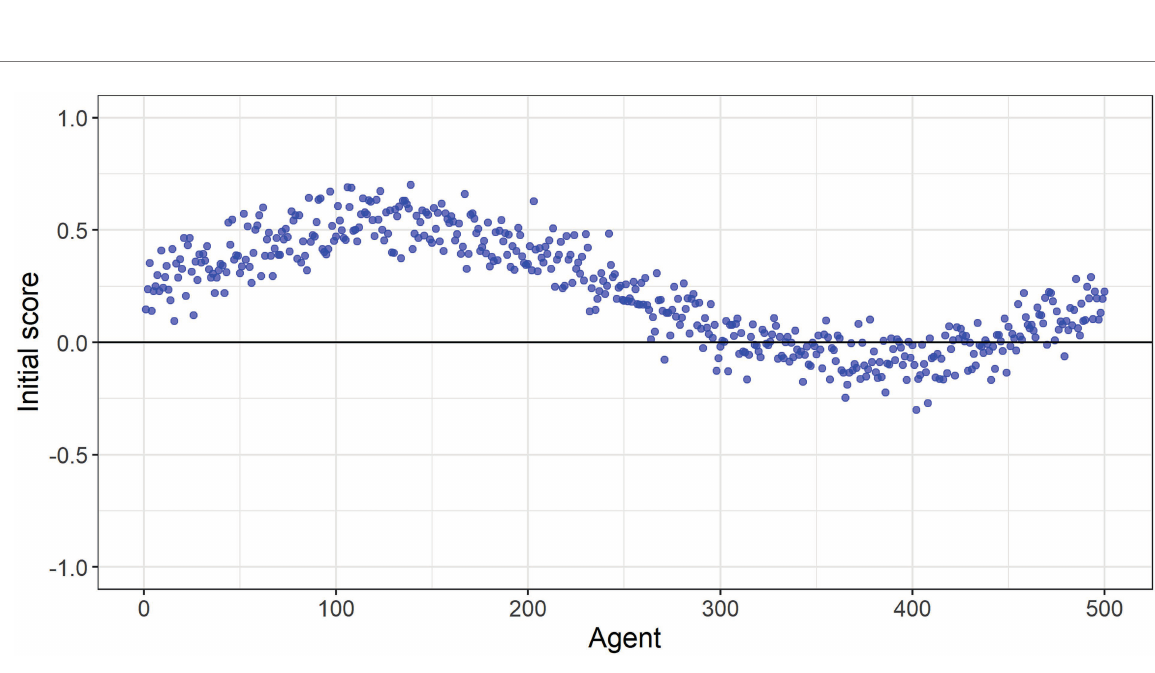
FIGURE 4 Individuals’ initial scores. Any agent with a score above zero does the behaviour. In the ring lattice the i th agent’s immediate neighbours are the